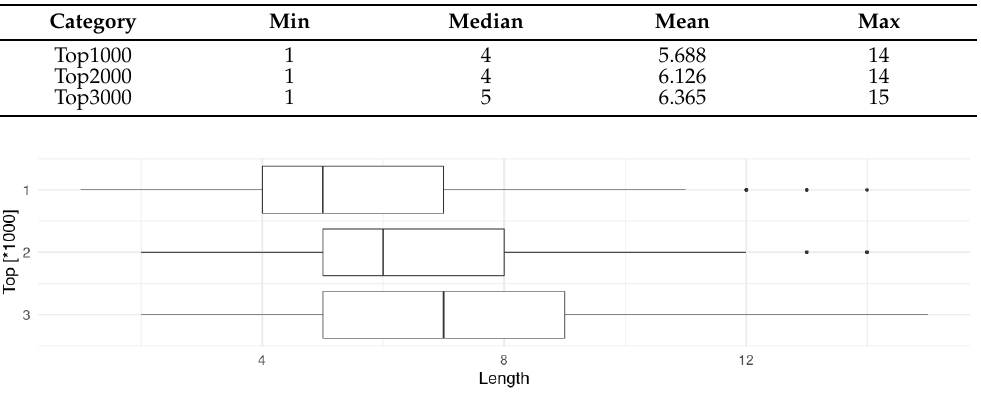
Figure 12. Graphical summary of lengths of most frequent words in English.